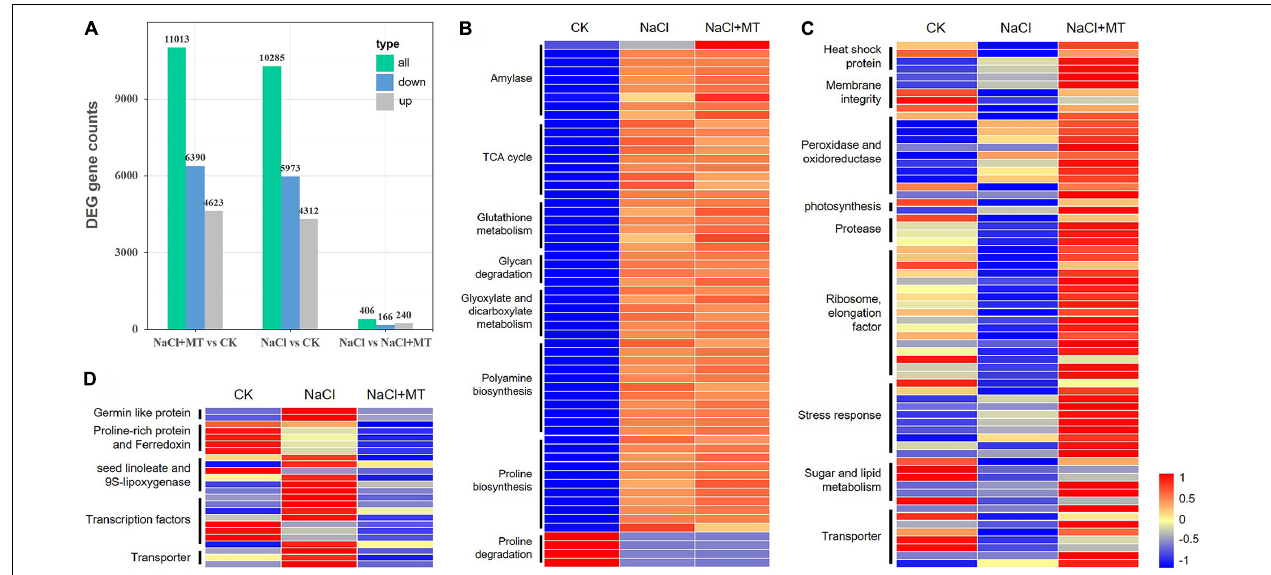
FIGURE 10 | Transcriptome responses of alfalfa seedling after treatment with NaCl and MT. CK, Water. NaCl, 250 mM. NaCl + MT, 250 mM NaCl + 150 µ M MT. Seeds were germinated for 10 days under different treatments, and total RNAs of root tissue with three biological replicates from each treatment were used for transcriptome sequencing and identification of differentially expressed genes (DEGs). (A) The number of DEGs in different comparisons. “Up” represents upregulated genes and “Down” represents downregulated genes. (B) The DEGs showed similar expression patterns in NaCl and NaCl + MT groups compared with control (CK). (C) The upregulated genes in NaCl + MT compared with NaCl alone. (D) The downregulated genes in NaCl + MT compared with NaCl alone. Hierarchical cluster heatmap was drawn by MeV software, and log2 (RPKM) values for the DEGs are indicated in different colors. Gene annotation is shown on the